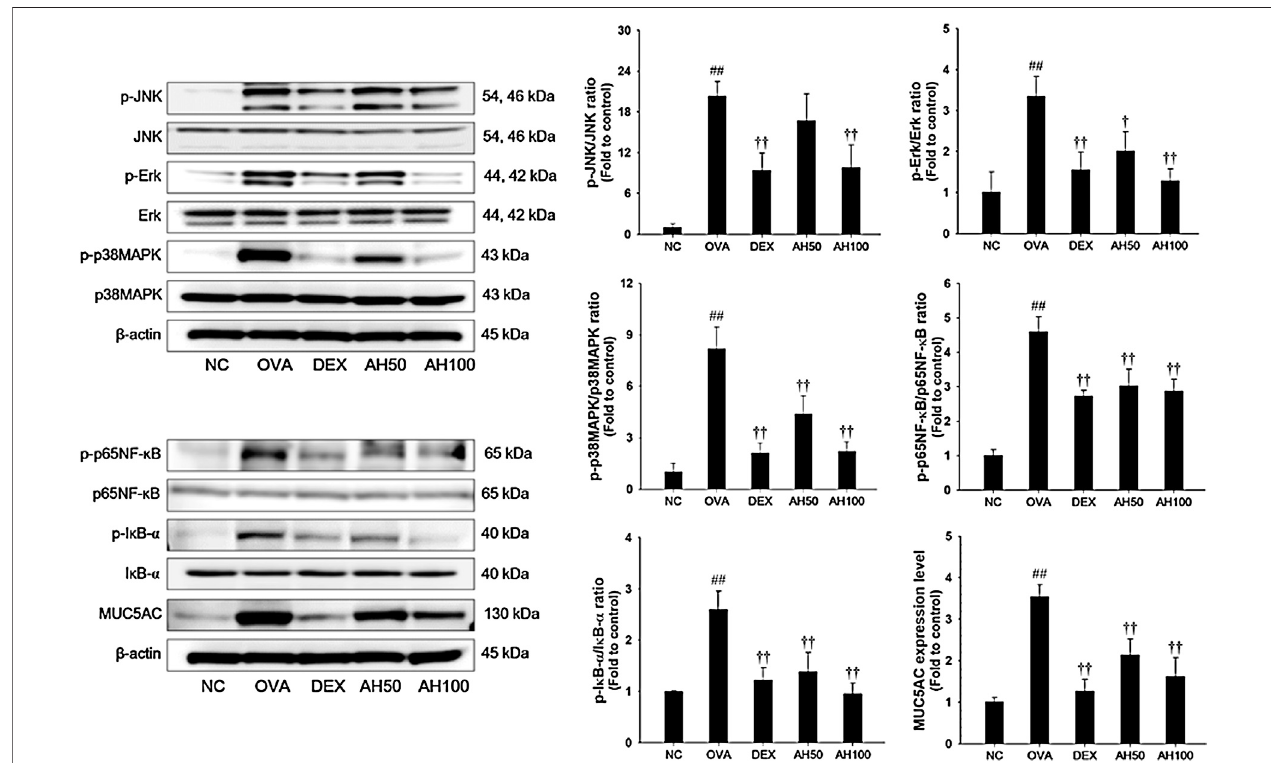
FIGURE 5 | AH inhibited phosphorylation of MAPKs/p65NF- κ B and expression of MUC5AC in lung of mice 48 h after fi nal OVA challenge. The protein levels of MAPKs/p65NF- κ B and MUC5AC in the total lung tissues were determined by western blot analysis. β -actin was used to con fi rm equal protein loading. NC: normal control mice; OVA: OVA-challenged asthma mice; DEX: dexamethasone (3 mg/kg) + OVA-challenged asthma mice; AH: AH (50 or 100 mg/kg) + OVA-challenged asthma mice. The values are expressed as the means ± SD (n (cid:2) 7/group). ## p < 0.01, signi fi cantly different from NC group; † , †† p < 0.05, p < 0.01, signi fi cantly different from OVA-challenged